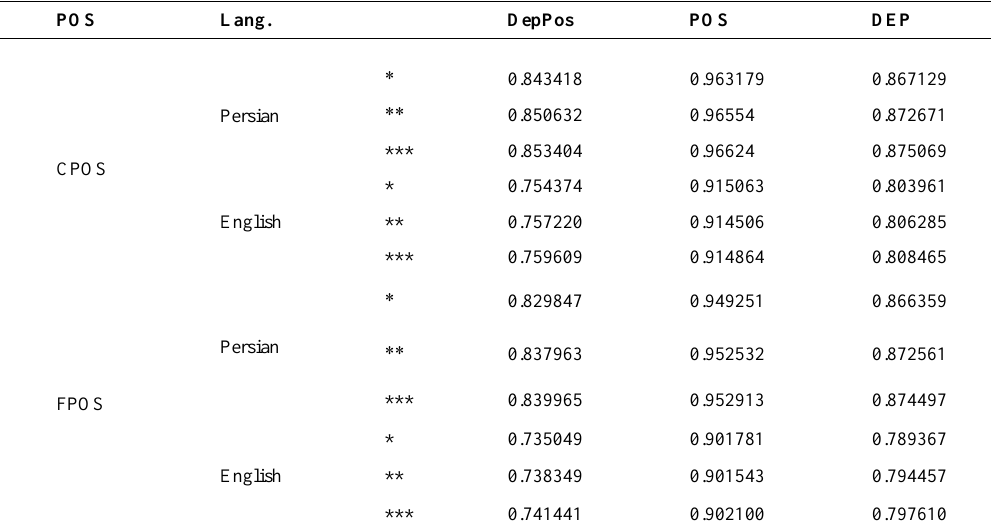
Table 8. Joint model accuracy on validation dataset with 5 iterations, before adding features of table 3, after adding features of table 3, after adding features of table 3 and reducing features of table 4.